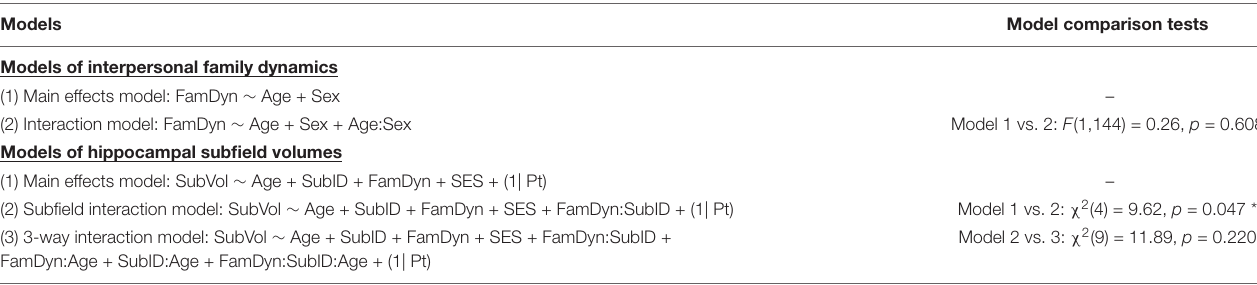
TABLE 2 | Models compared for main analyses.